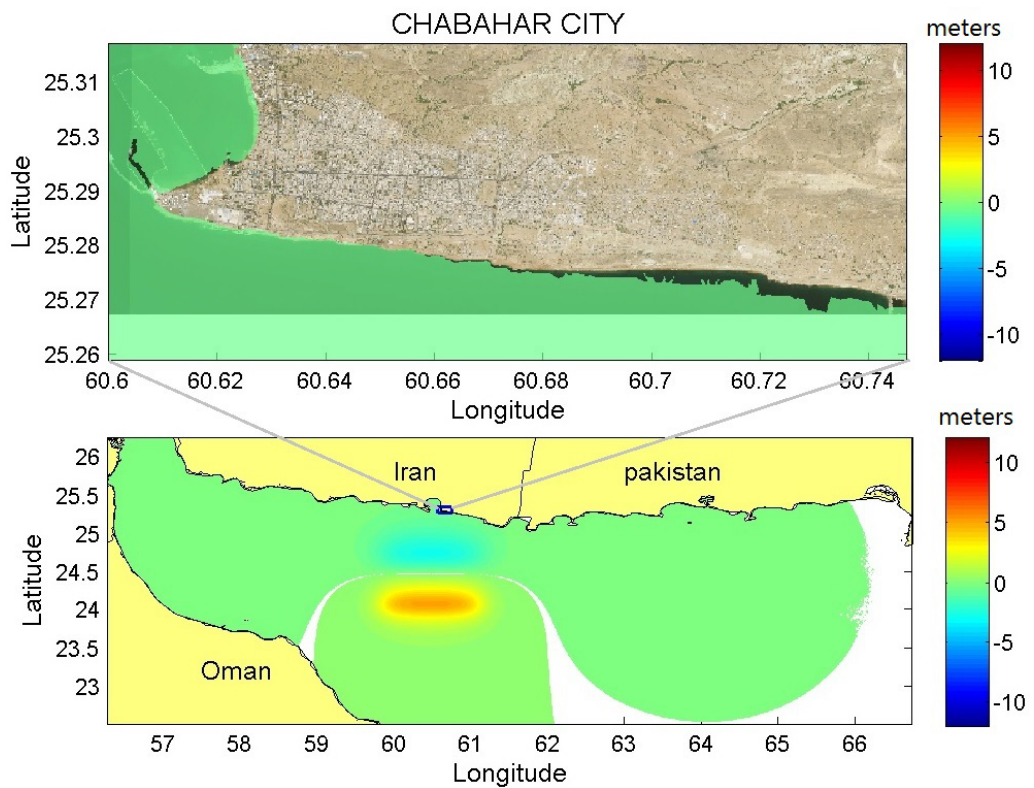
Figure 1. Output tsunami modeling at generation time step. The down image illustrate sea level deformation in effect of worst case scenario tsunami in Makran fults with 30 arc seconds (980 meters) resulation and upward image illustrate coastal level deformation in effect worst case tsunami scenario in Chabahar port, with 15 meters resulation, proper for tracking